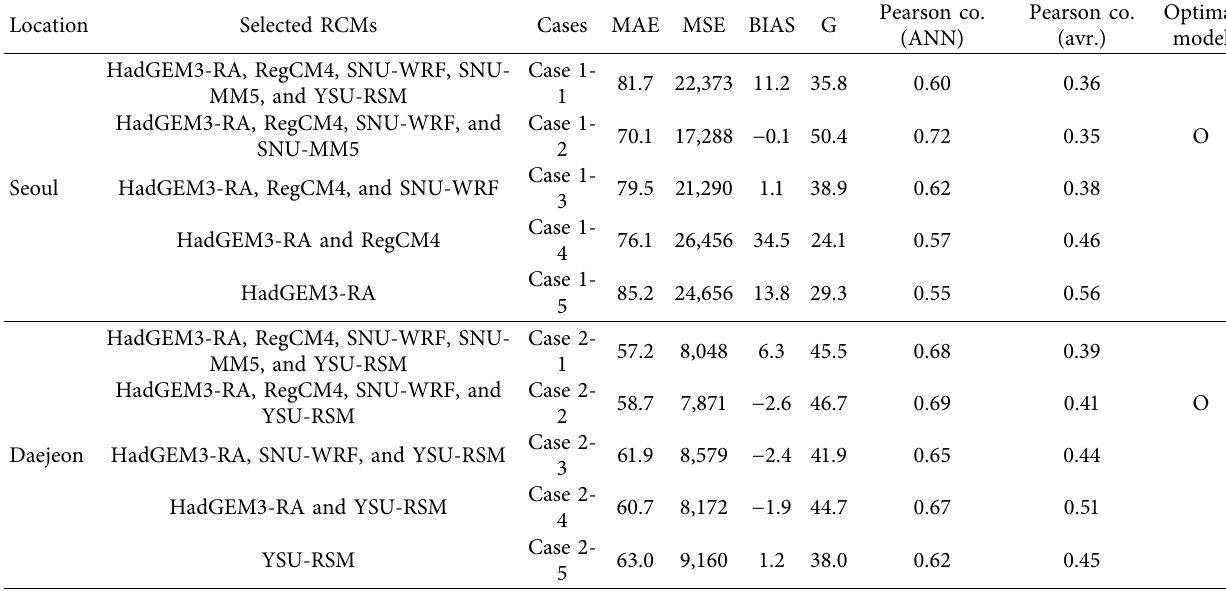
Figure 4: Results of accuracy assessment between ANN simulation and RCMs: (a) MAE, (b) MSE, (c) G value, and (d) BIAS. Table 4: Accuracy assessment results by ANN